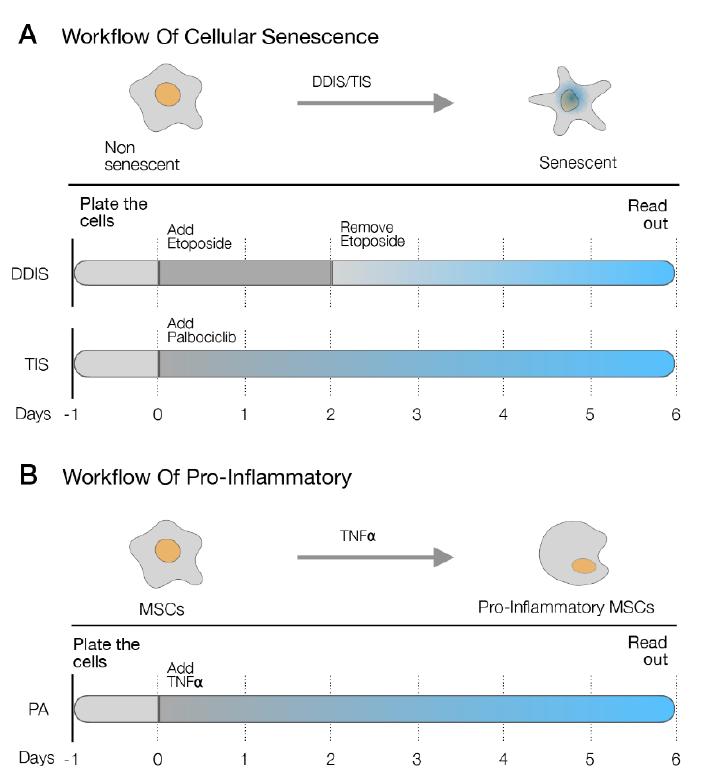
Figure 2. Schematic representation of ( A ) two cellular senescence models in MSCs: DNA damage- induced senescence (DDIS) (up) and therapy-induced senescence (TIS) (bottom) and ( B ) the proinflammatory activation (PA) model in mesenchymal stem cells (MSCs) using tumor necrosis factor α (TNF-α).